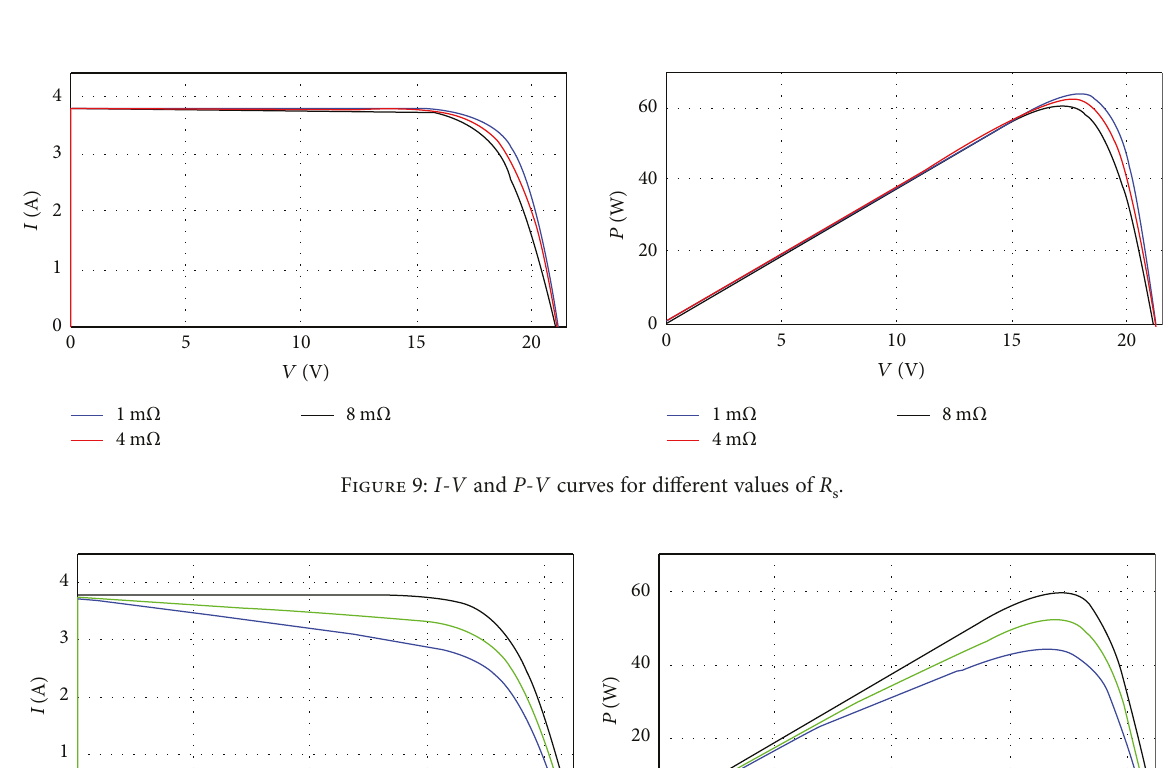
Figure 8: I ‐ V and P ‐ V curves for di ff erent values of temperature.